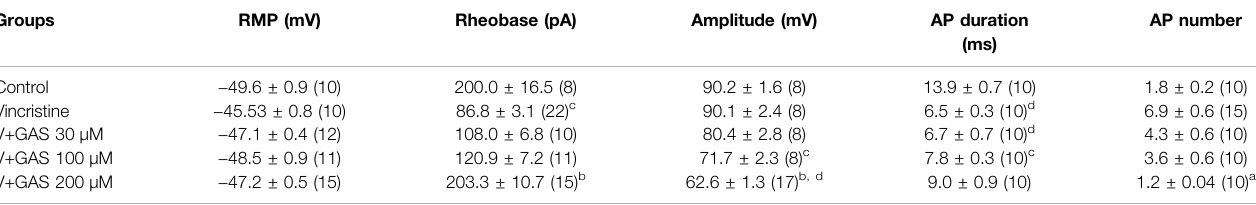
a Compared with vincristine group, p < 0.05. b Compared with vincristine group, p < 0.01. c Compared with control group, p < 0.05. d Compared with control group, p < 0.01. All data are given as the mean ±